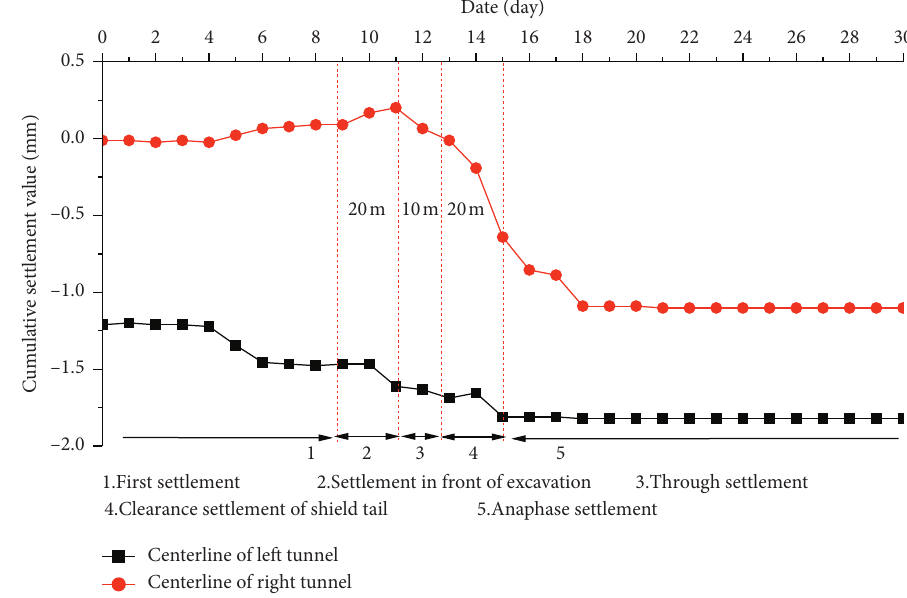
Figure 17: The settling time curve of the ground when the right-line shield passes through (grouting